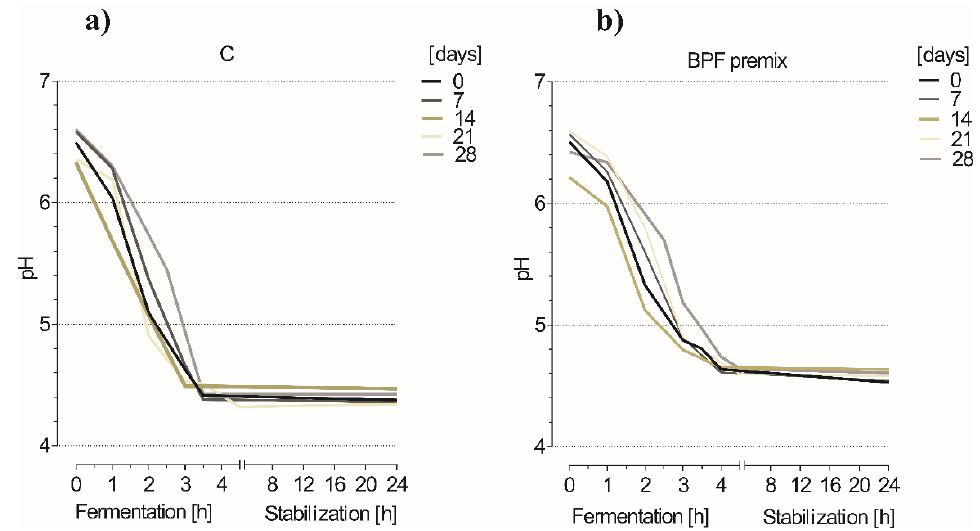
Figure 2. Decrease in pH values during yogurt production ( a ) without (control (C)) and ( b ) with 3% BPF premix. Yogurt samples were prepared weekly with neat starters and the BPF premix stored for up to 28 days (4 °C).